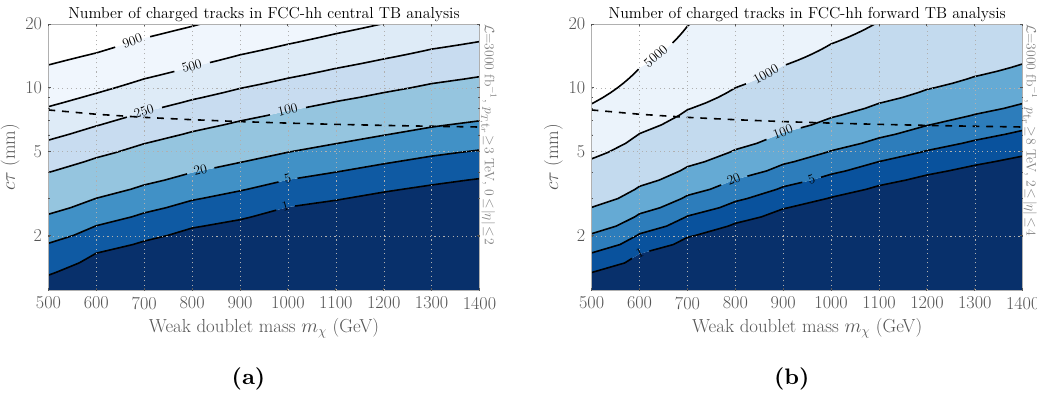
Figure 8. Number of charged tracks in (a) central TB analysis (b) forward TB analysis, normalized to the NLO cross section of a pair-produced weak-doublet fermion with Dirac mass m (cid:31) and nominal decay length c(cid:28) . The c(cid:28) corresponding to a pure-Higgsino state is shown as a dashed